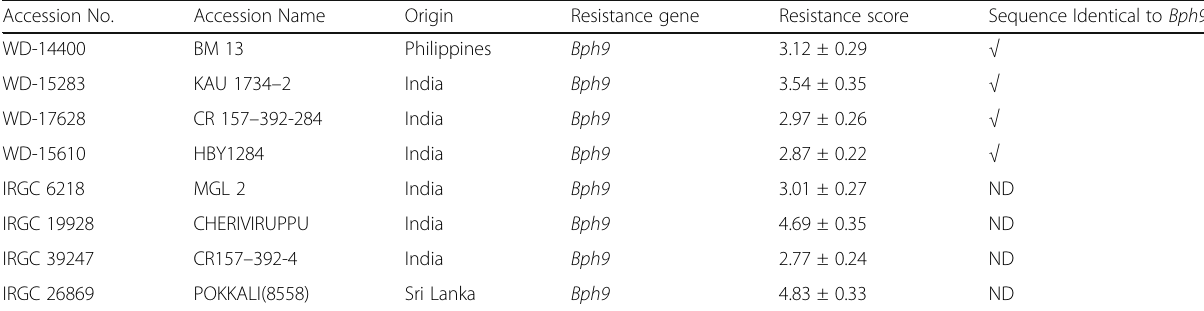
Table 4 Rice cultivars harboring Bph9 identified by B9D Accession